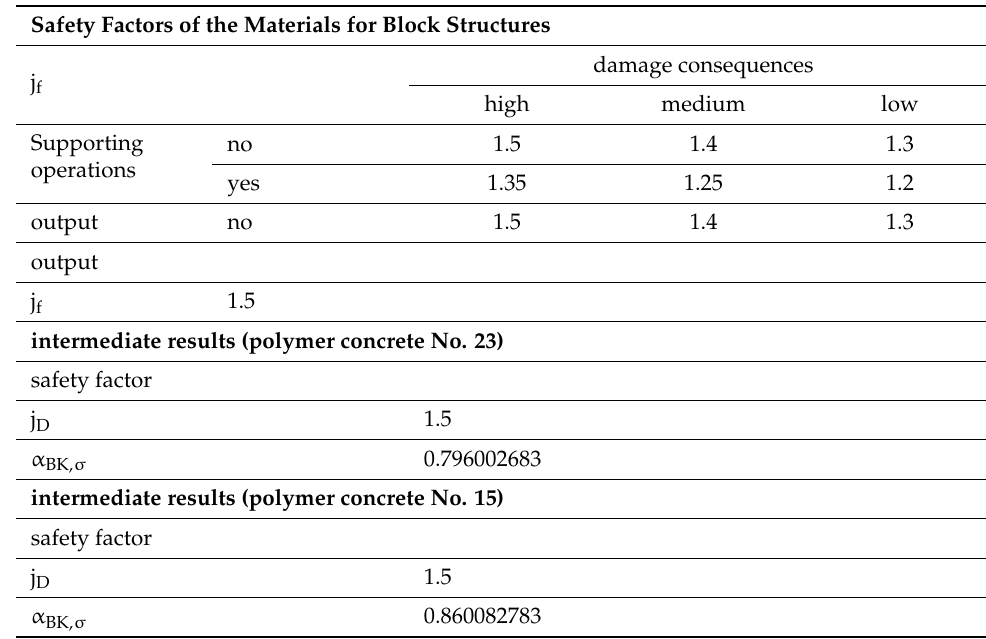
Table 8. The results of polymer-concrete operation with high amplitude